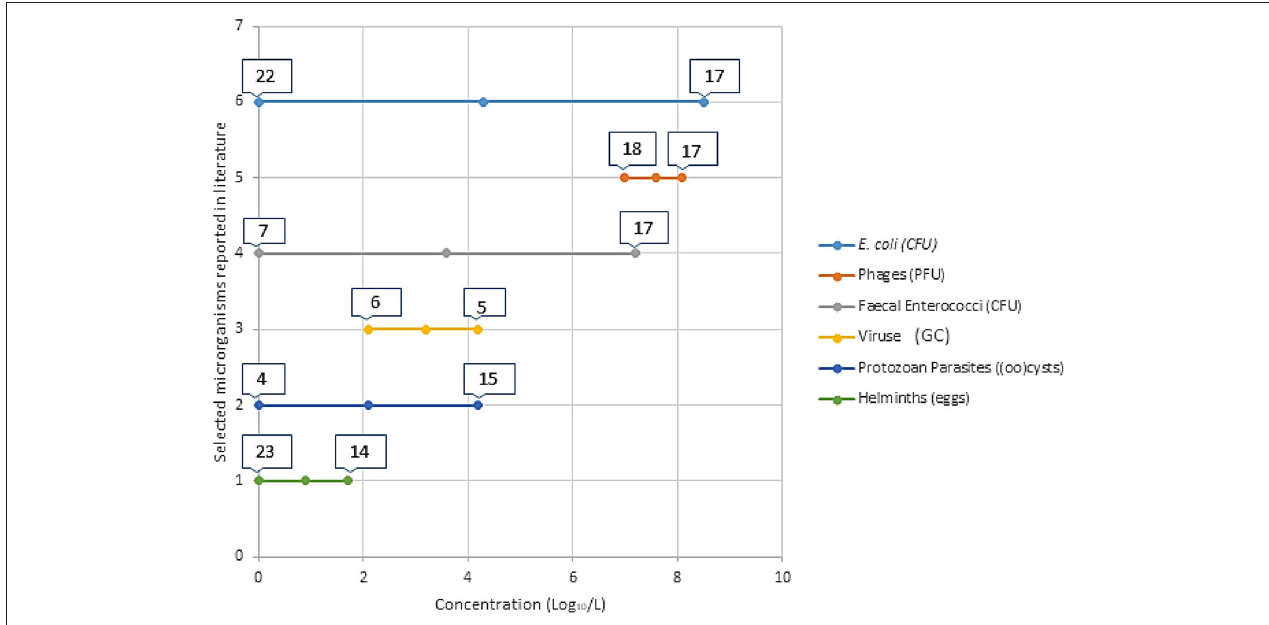
FIGURE 1 | Visual representation of minimum and maximum concentration (Log 10 / L) of selected microorganisms in partially treated and untreated wastewater intended for reuse. The numbers on the bars represents the individual references with these reported concentrations. These articles are referenced in Table 1, where further information is provided. This is a brief introduction of the different concentrations reported in literature for the different categories of microorganisms. Table 1 gives detailed information on the literature added in this